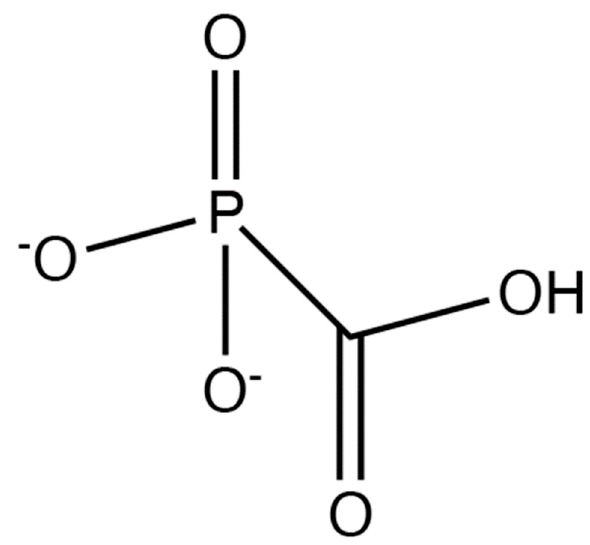
Figure 3. Foscarnet.